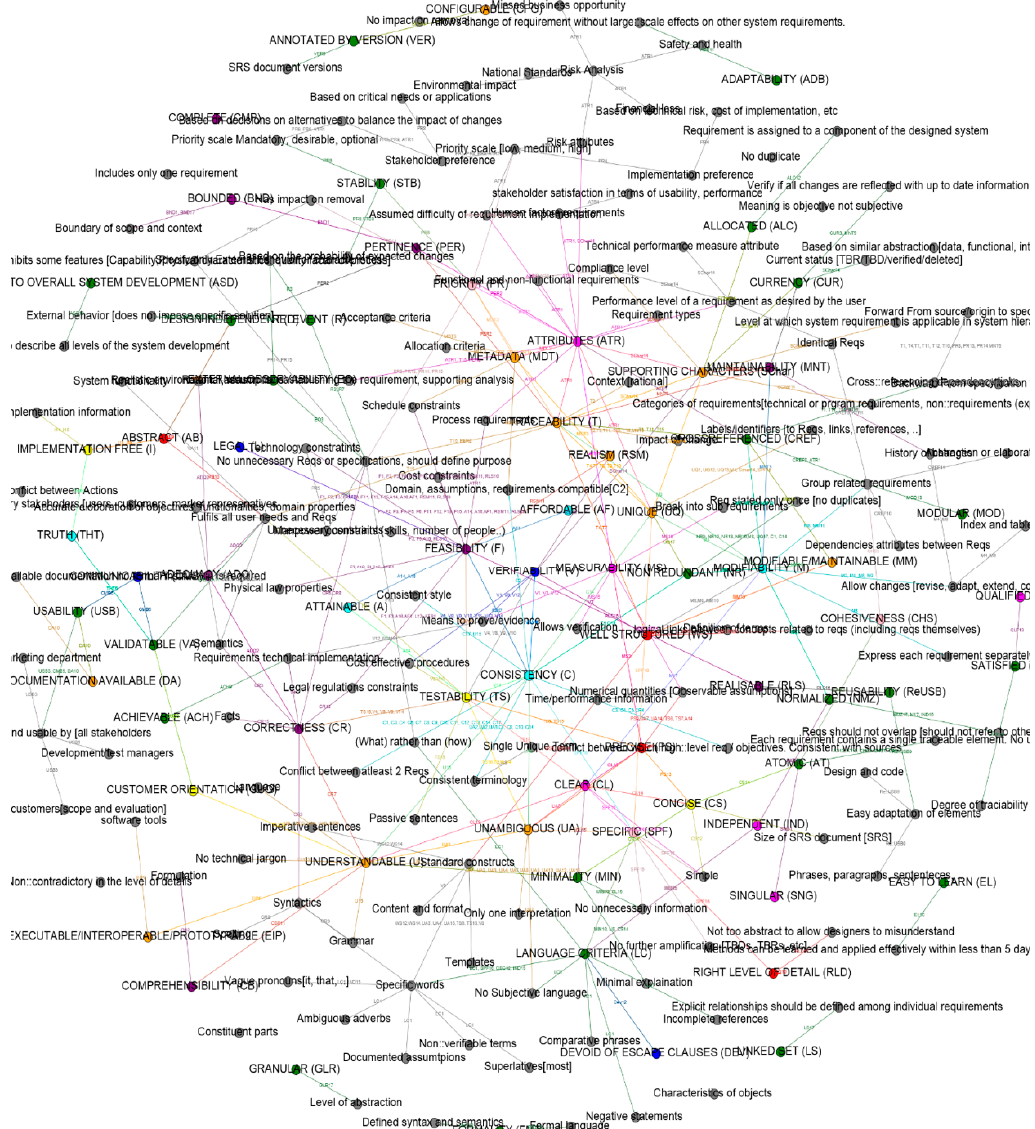
Figure 2. Complete view of the criteria conceptual graph.